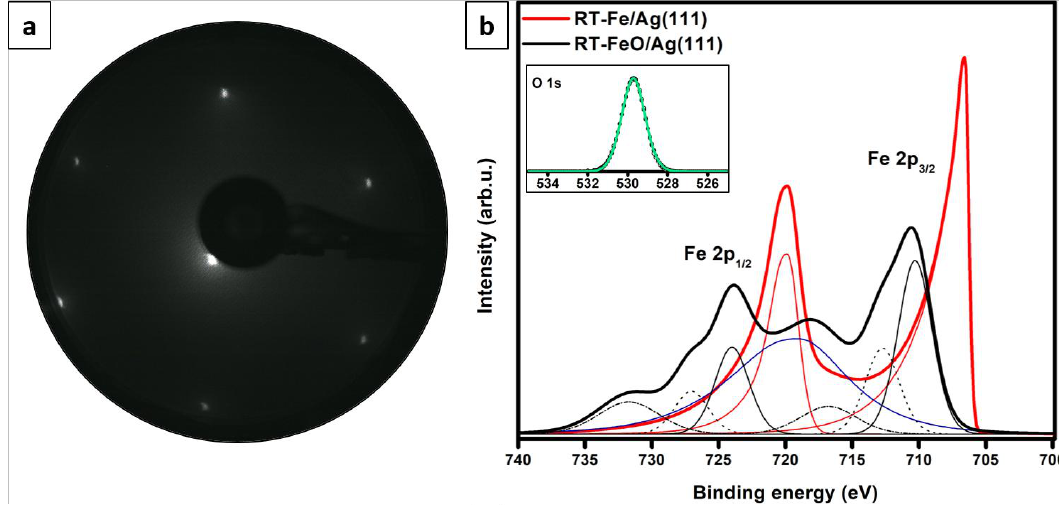
Figure 2. Low energy electron diffraction (LEED) pattern (60 eV) of 0.5 ML FeO film grown by Fe deposition onto Ag(111) substrate kept at room temperature and post-oxidation ( a ). ( b ) shows Fe 2p X-ray photoelectron spectroscopy (XPS) spectra obtained for the 1.0 ML RT-Fe/Ag(111) (red line) and 1.0 ML RT-FeO/Ag(111) (black) samples. The Ag 3s signal, overlapping with the Fe 2p line, is marked in blue. Inset in (b) presents the O 1s spectrum (green line) recorded for the oxidized sample. The XPS data recorded for the 1.0 ML RT-Fe/Ag(111) and 1.0 ML RT-FeO/Ag(111) samples The Fe 2p signal obtained for the RT-Fe/Ag(111) sample could be fitted with two components centered at around 706.5 eV and 719.9 eV, which are characteristic of metallic iron and result from spin-orbit coupling (Fe 2p 3/2 and 2p 1/2 peaks [45]). The spectrum obtained for the oxidized sample